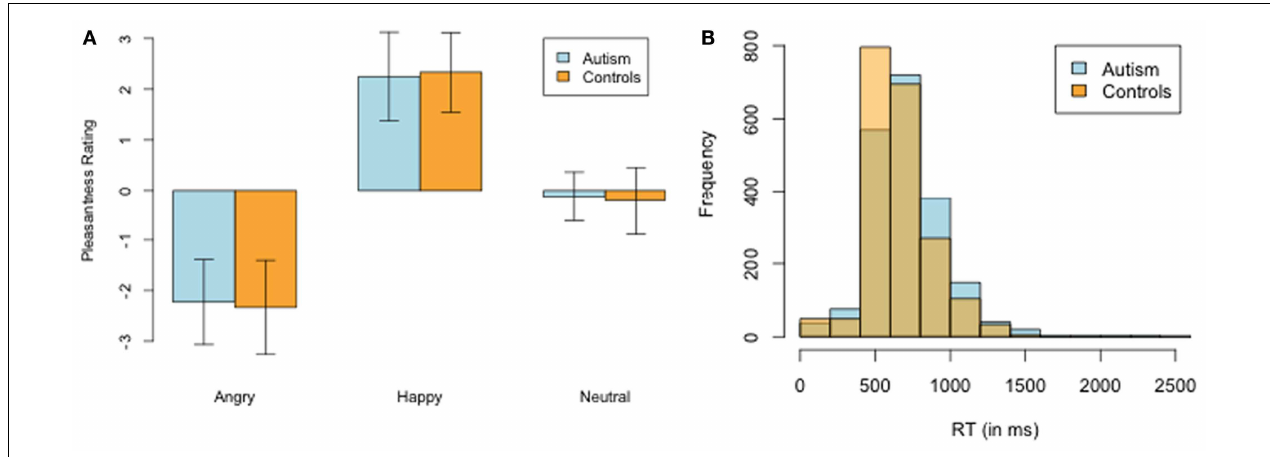
FIGURE 2 | Ratings of social stimuli. (A) Pleasantness ratings of the happy, neutral, and angry social stimuli.There were no significant differences between groups on any of the categories. (B) Distribution of mean reaction-times between ASD and